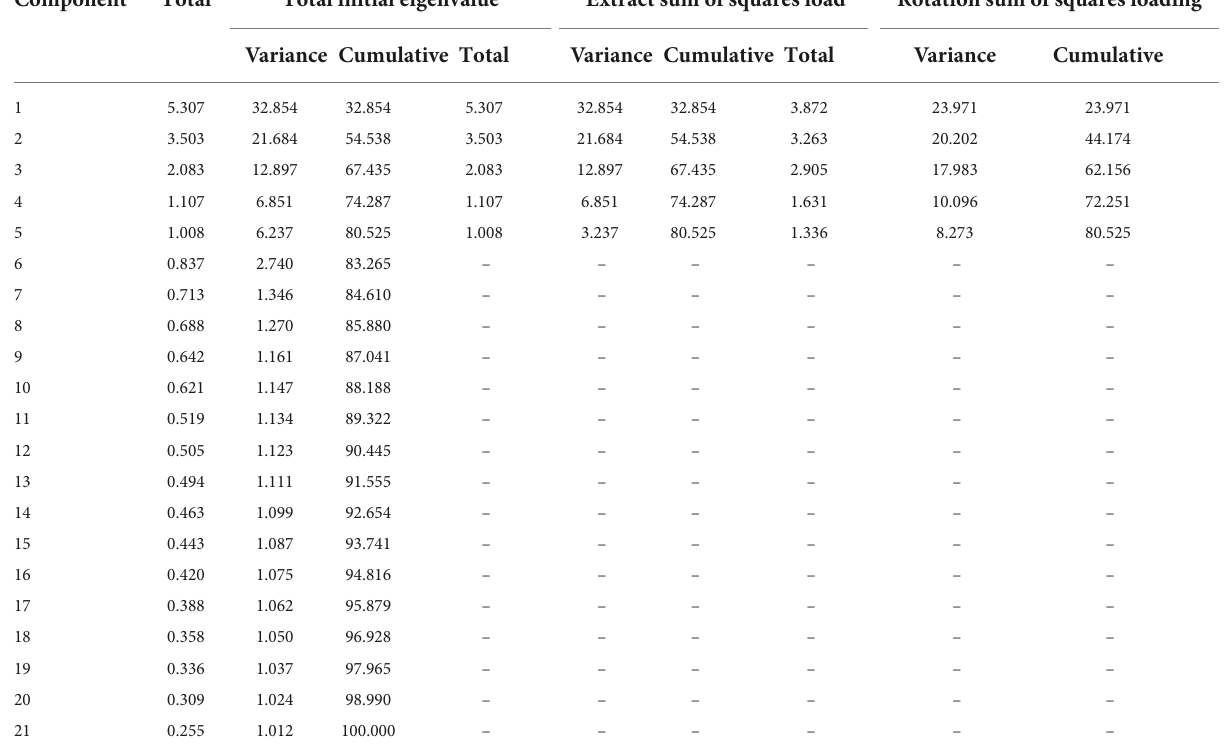
TABLE 6 Total variance